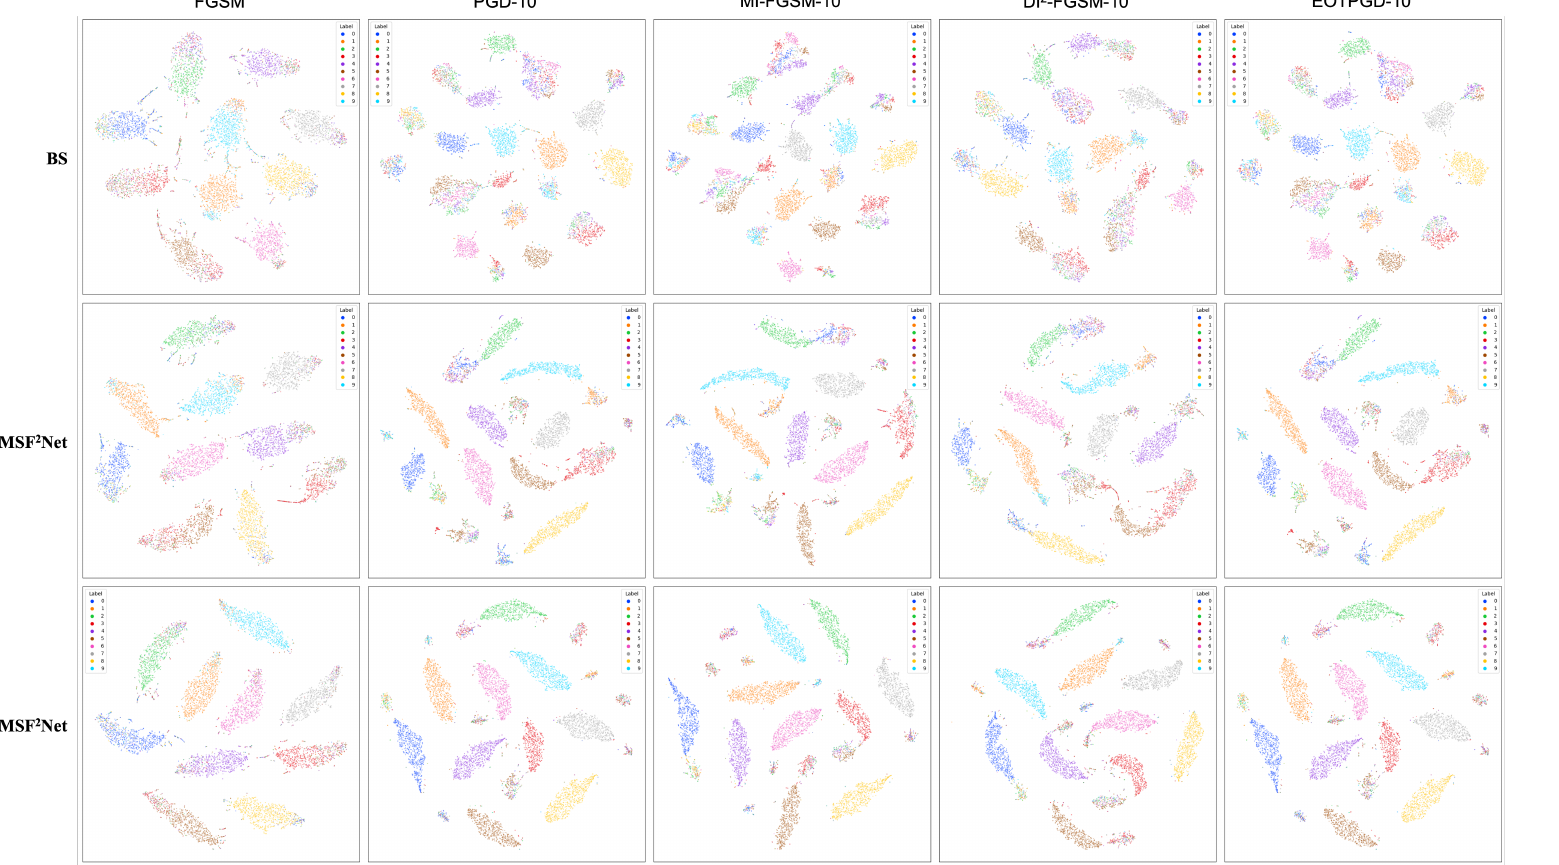
Figure 9. t-SNE visualization results of the baseline, MSF 2 Net, and EMSF 2 Net under the L ∞ -norm attacks with less complexity on the CIFAR-10